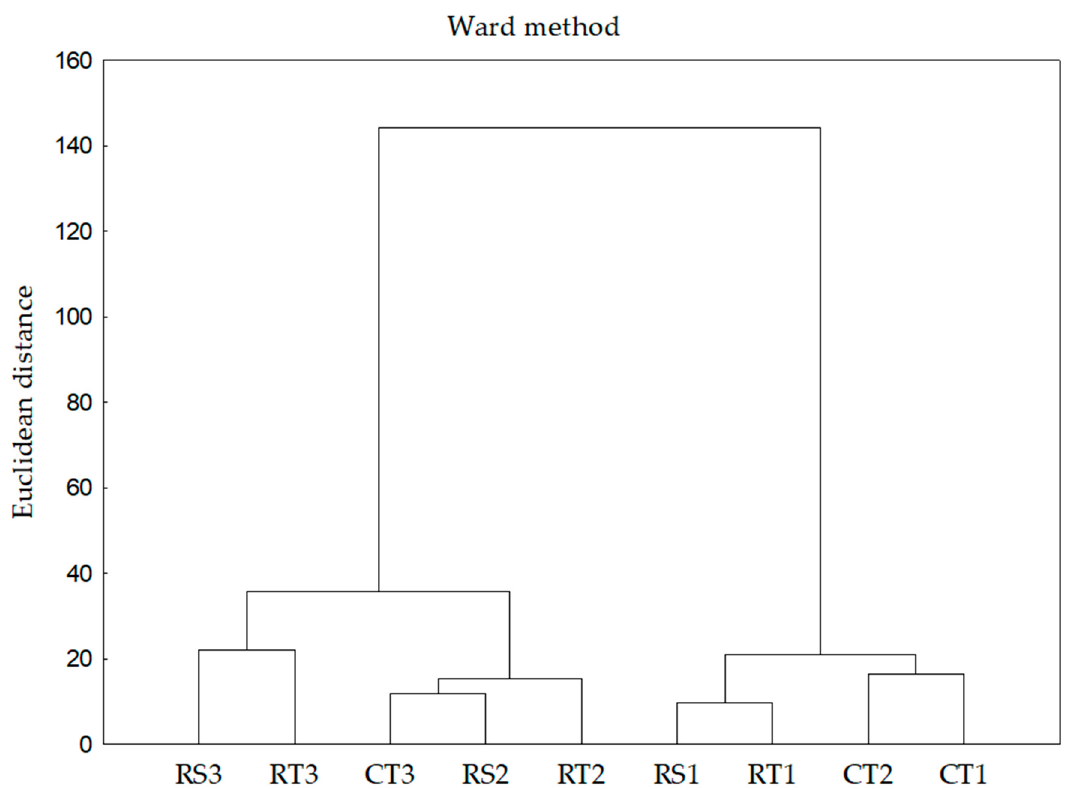
Figure5. Clusteranalysisdeterminedfromthefollowingparameters: contentofTOC,Nt, DOC,andDNt Figure 5. Cluster analysis determined from the following parameters: content of TOC, Nt, DOC, and and the share of DOC, DNt, C(N) d , C(N) HAs , C(N) FAs , C(N) h , and the TOC / Nt and C HAs / C FAs DNt and the share of DOC, DNt, C(N) d , C(N) HAs , C(N) FAs , C(N) h , and the TOC/Nt and C HAs /C FAs ratios.